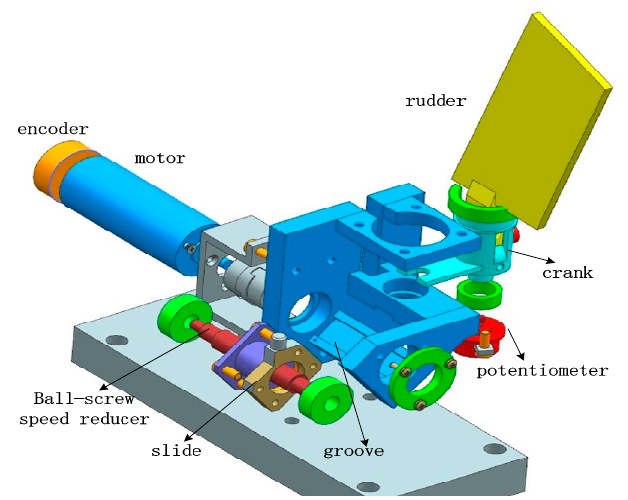
Figure 1. The structure of the electromechanical actuator systems.